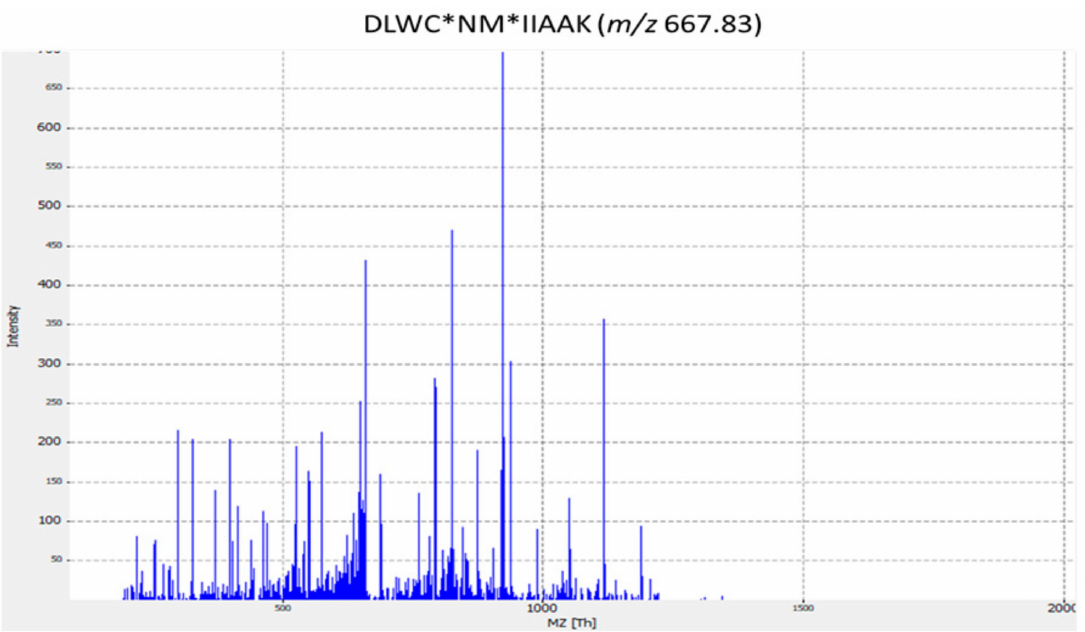
Figure 2. MS / MS spectrum for DLWC*NM*IIAAK Streptococcus dysgalactiae -specific peptide biomarker. The corresponding peptides were tested for specificity using the BLASTp